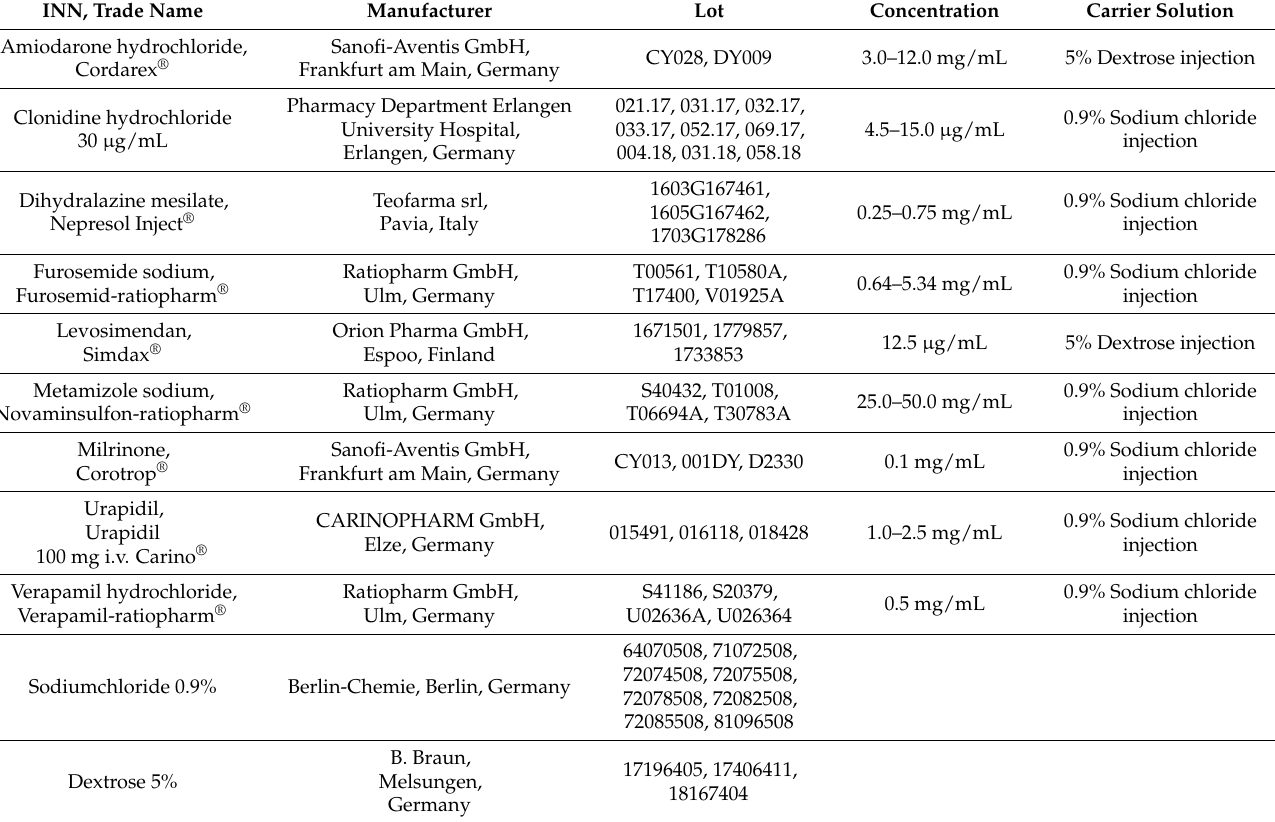
Table 1. Drugs and standard concentrations tested for